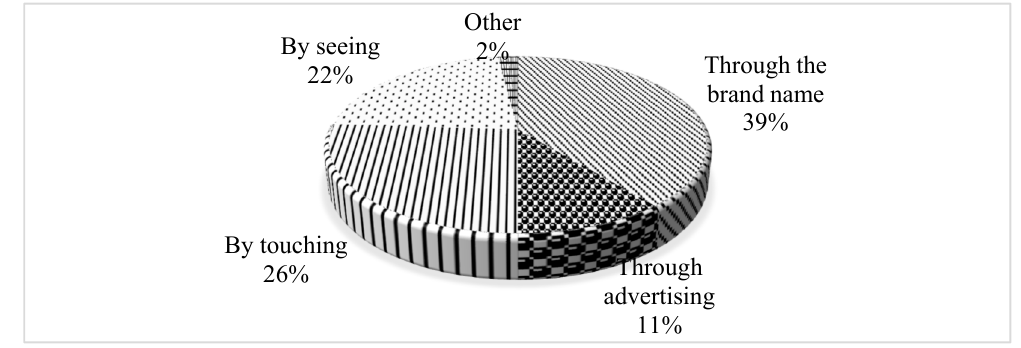
Figure 3. Means of recognizing the locally-produced rice. Source: Field survey, 2017.